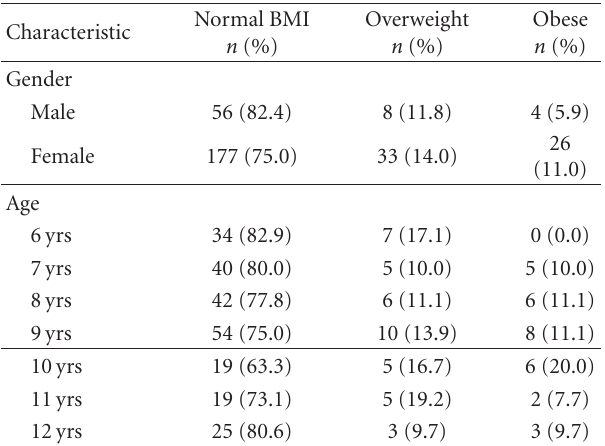
Table 1: Age and gender by BMI status.